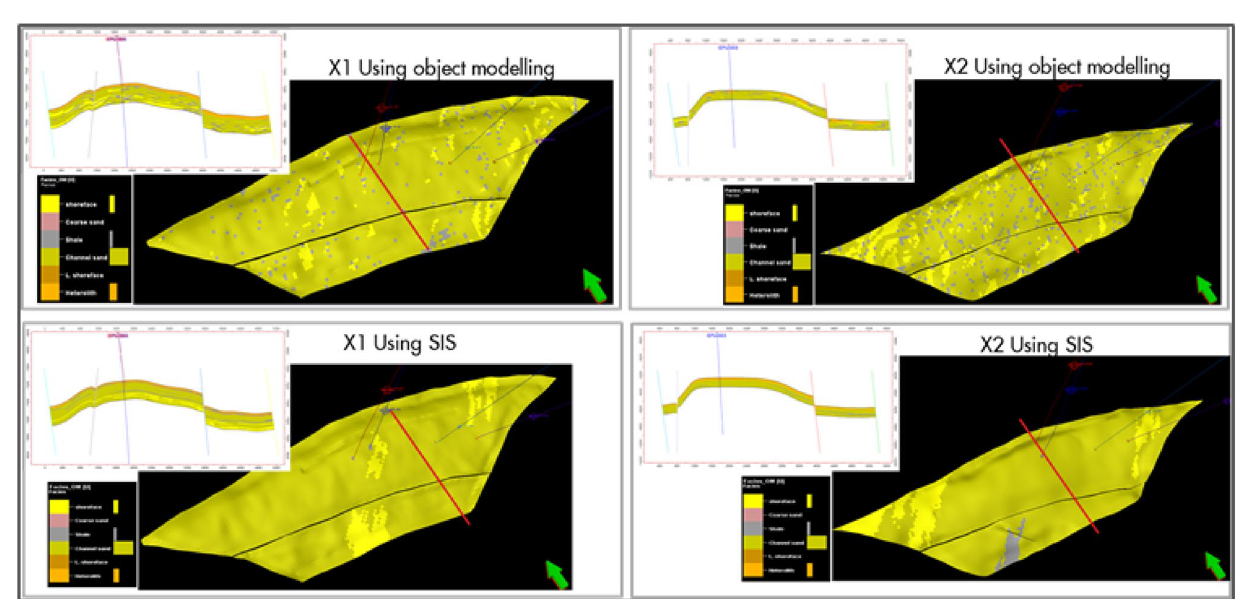
Fig. 16 Facies model showing distribution of facies in X1 and